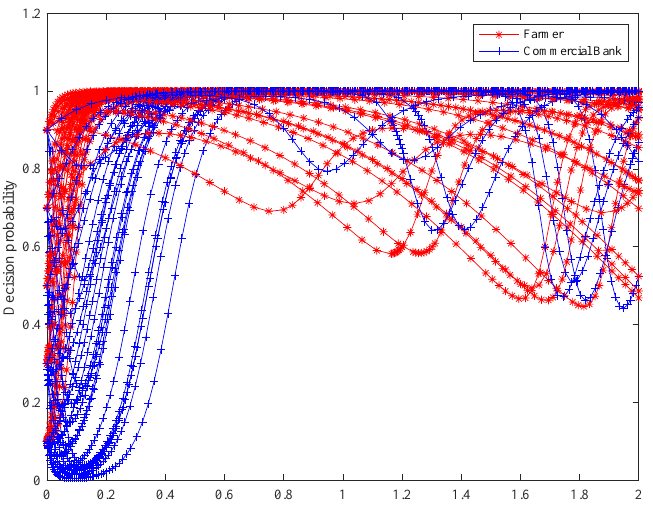
Figure 5. System evolution track before introducing blockchain Technology ( P =